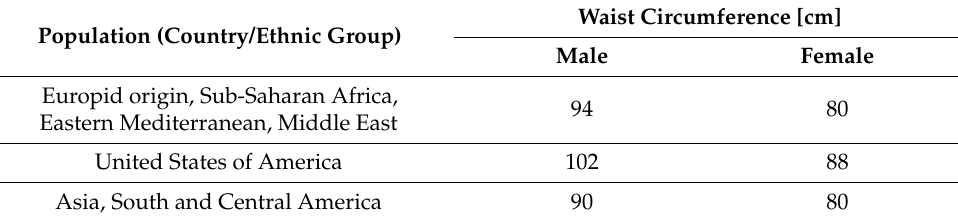
Table 1. Population- and gender-specific cut-off values of waist circumference for the diagnosis of metabolic